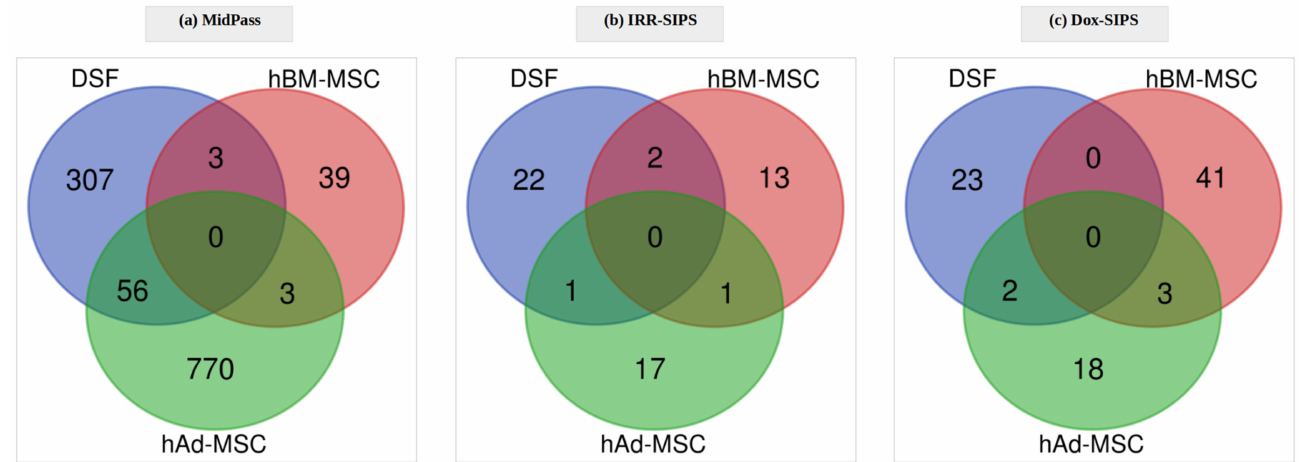
Figure 7. Genes shared among the three cell types after ( a ) a middle number of passages (MidPass), ( b ) irradiation-induced senescence (IRR-SIPS) and ( c ) doxorubicin-induced senescence